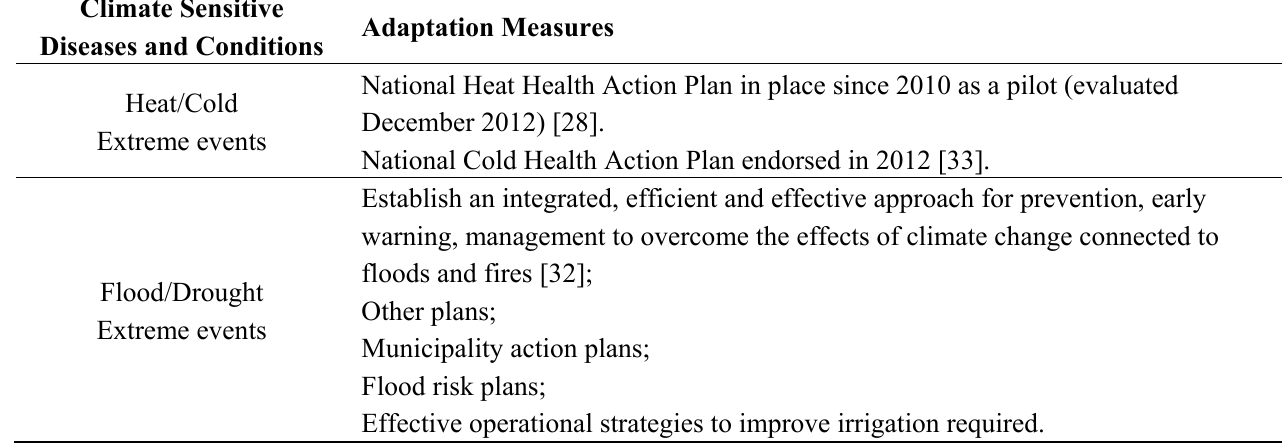
Table 4. Proposed adaptation measures for the national health adaptation